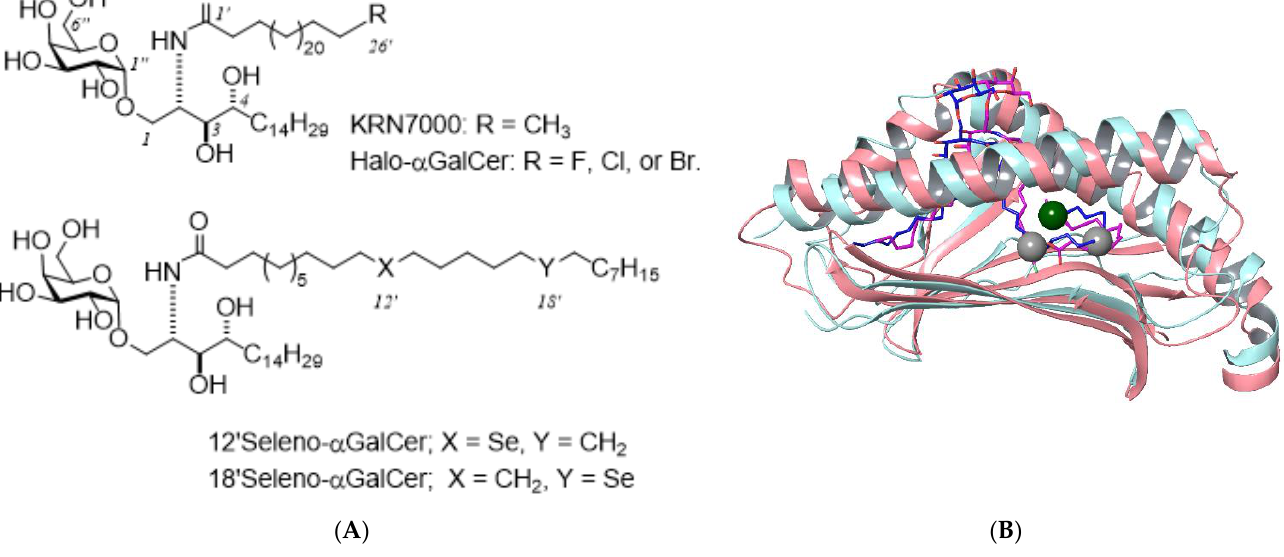
Figure 6. Structures of heavy atom derivatives of α -galactosylceramide and binding model with CD1d. The chemical structures of α -GalCer derivatives with terminal halogens or selenium ( A ), and the superposed structures of murine CD1d complexed with Th1-selective ligand C8PhF (PDB ID: 3GMO; pink ribbon and purple wire) and that with KRN7000 (PDB ID: 3HE6; sky-blue ribbon and blue wire) ( B ). C26′ of KRN7000 is shown as a dark green ball and C12′/C18′ are shown with gray balls, which corresponded to halogen and selenium positions of the synthetic analogues, respectively.